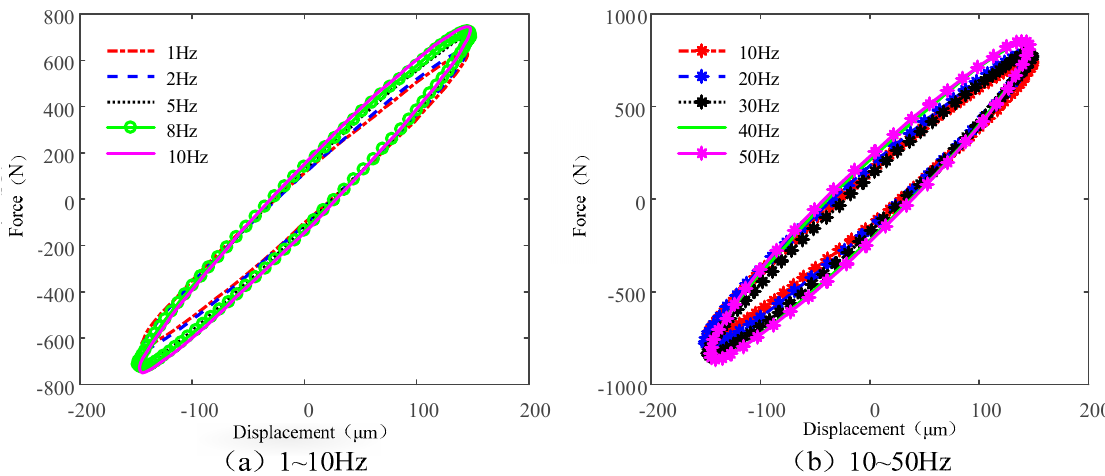
Figure 6. The hysteresis curves of specimen Y02 at the same displacement amplitude with different frequencies: ( a ) 1~10 Hz, ( b ) 10~50 Hz.